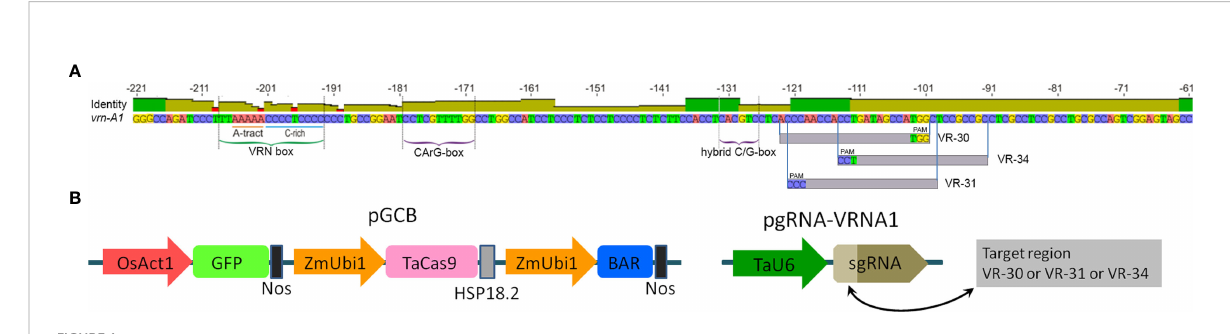
FIGURE 1 (A) Structure of the recessive vrn-A1 promoter sequence of ‘ Chinese Spring ’ and target locations used for sgRNA vector design. (B) Schematic structure of linearized Cas9 and sgRNA cassettes used for CRISPR/Cas9